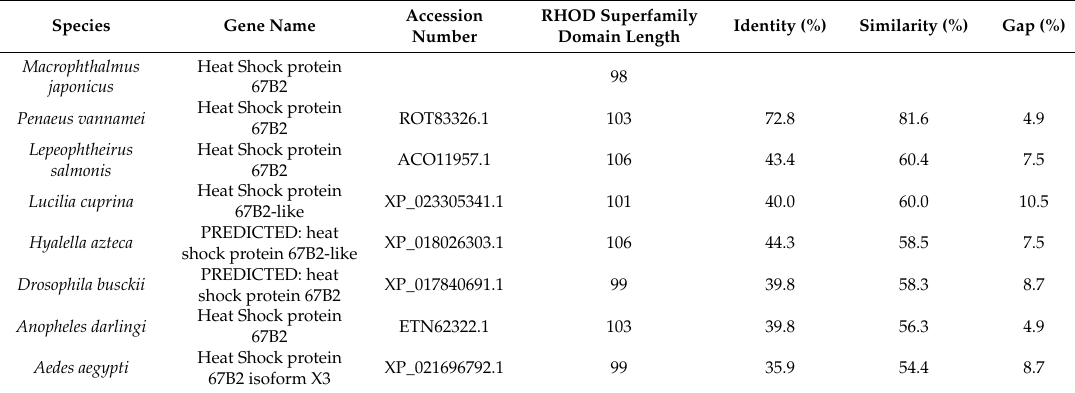
Figure 2. Sequence information for Macrophthalmus japonicus HSP67B2 identified in this study. ( A ) An open reading frame (ORF) of Mj-HSP67B2 was predicted using the ExPASy tool and is represented by a black box. The yellow box indicates a RHOD superfamily domain. ( B ) Phylogenetic analysis of Mj-HSP67B2 with known HSP67B2 sequences from seven Arthropoda species. The phylogenetic tree is based on amino acid sequences translated from Mj-HSP67B2 ORF by the neighbor joining method (bootstrap value 1000) using MEGA X software. The numbers at the nodes represents the bootstrap majority consensus values for 1000 replicates. GenBank accession numbers are shown with the scientific and common names of each species. Table 1. Percentage identity, similarity, and gaps involving Macrophthalmus japonicus HSP67B2 and HSP67B2 homologs from other species at the amino acid